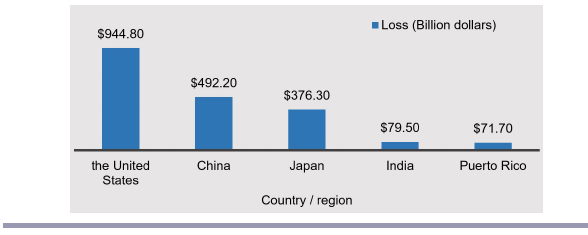
Fig. 1 . Top five countries/regions for disaster losses from 1998 and